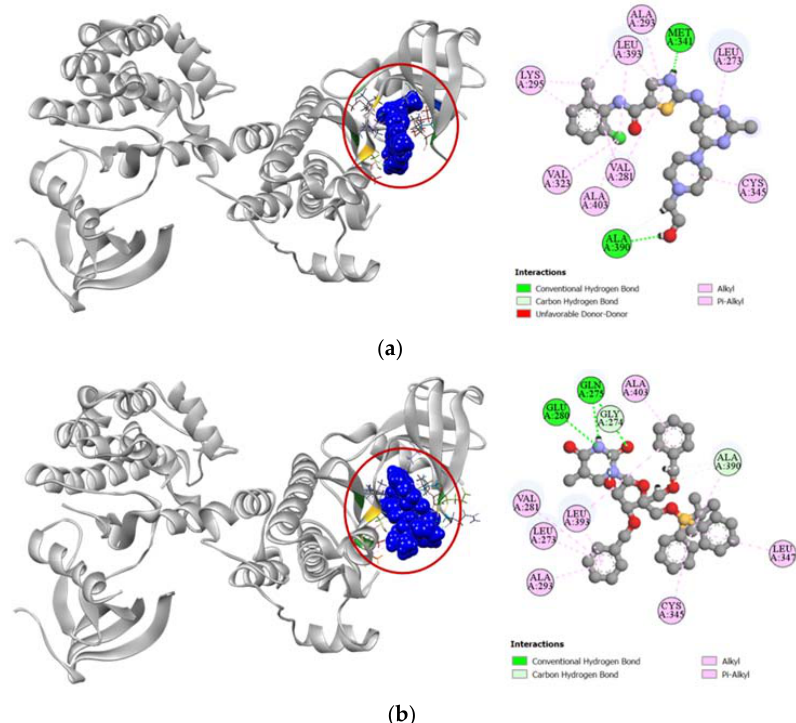
Figure 6. Pictorial representation (2D and 3D) of docking results for best-ranked pose of key inter- actions of ligands with the binding pocket of human cytidine deaminase (PDB: 1MQ0). ( a ) 1-beta- ribofuranosyl-1,3-diazepinone with 1MQ0; ( b ) compound 6 with 1MQ0. 2.3.5. Inhibition of Proto-Oncogene Tyrosine-Protein Kinase Src Standard cytotoxic drug dasatinib is an extremely strong inhibitor of the proto-onco- gene tyrosine-protein kinase Src (PDB: 3G5D), which is confirmed by our molecular dock- ing simulation where it had a high docking score of − 9.4 kcal/mol. Compared to the stand- ard, compound 6 had a moderately high docking score of − 7.6 kcal/mol (Table 4). Binding interactions with the active site of the protein revealed that compound 6 formed strong hydrogen bonds with GLY274, GLN275, GLU280, and ALA390 residues as well as other alkyl and pi-alkyl hydrophobic interactions with several residues. Compound 6 shared similar docking sites as dasatinib with several residues of the tyrosine-protein kinase Src, which included LEU273, VAL281, ALA293, CYS345, ALA390, LEU393, and ALA403 (Fig- ure 7).